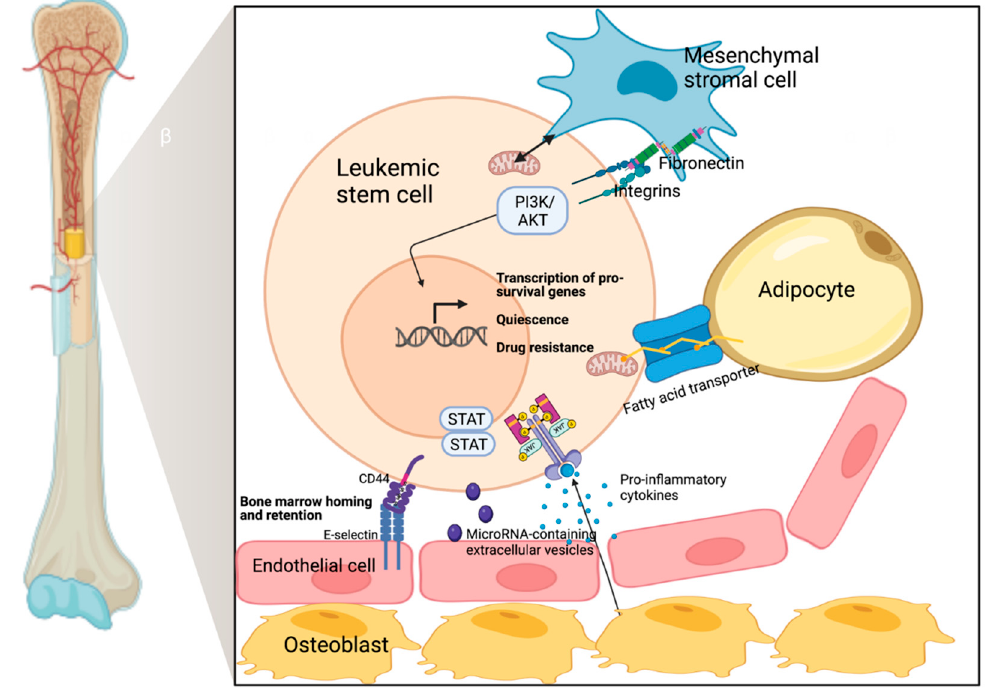
Figure 1. Stromal cellular signaling facilitates leukemic stem cell (LSC) survival, quiescence, and drug resistance. LSCs engage in bidirectional crosstalk with multiple BM cellular constituents. E- selectin expressed on the surface of endothelial cells interacts with CD44 on LSCs to drive LSC homing and retention in the protective BM microenvironment, sheltering LSCs from therapeutic insults. Furthermore, endothelial cells also release microRNA (miRNA)-containing extracellular vesicles to further enrich the quiescence phenotype of LSCs. Osteoblasts primarily release proinflammatory cytokines that lead to the transcription of genes implicated in LSC survival, self-renewal, and quiescence. Mesenchymal stromal cells are known to physically transfer mitochondria to LSCs via nanotubes to repair and replace damaged mitochondria with new ones inside LSCs, potentially helping LSCs evade apoptosis. Mesenchymal stromal cells can also activate pro-survival integrin- mediated signaling in LSCs, involving the PI3K/AKT pathway. Moreover, adipocytes assist in the rewiring of LSC metabolism, supplying free fatty acids to fuel oxidative phosphorylation, a known metabolic dependency of